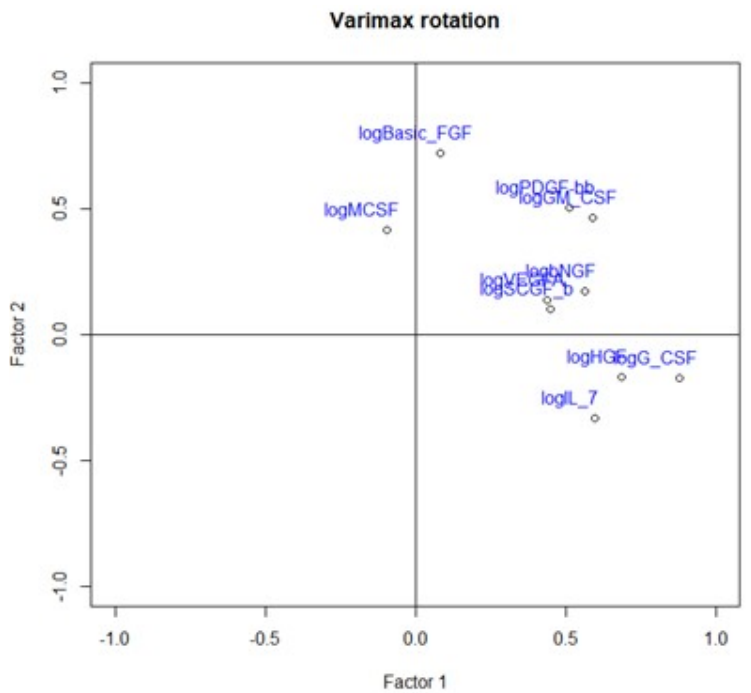
Figure 6. Loading plot presenting loading factors after varimax rotation to change positioning vector of the factors and provide easier interpretation of factor loadings. Table 4. Loadings of factors after varimax rotation.